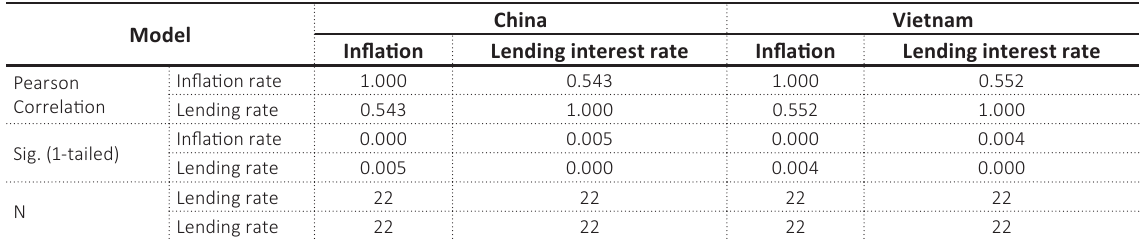
Table 7. Correlation between inflation and lending rates in China